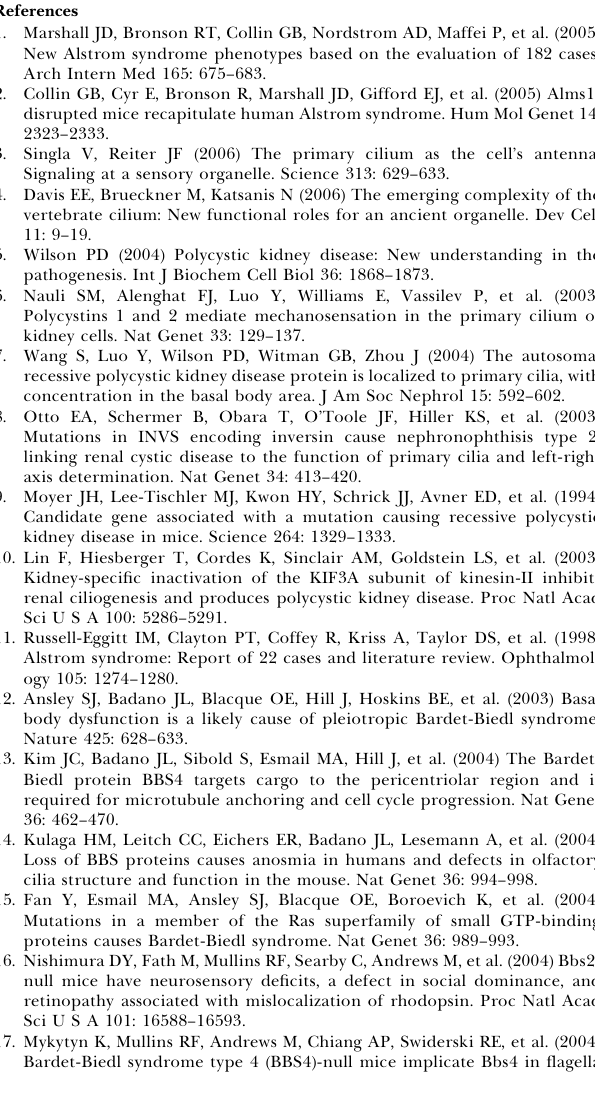
black shading denotes the included region for the position of the mutation and gray shading denotes the excluded region. Map positions refer to public mouse genome assembly M33 (http://www. ensembl.org/Mus_musculus/index.html). (B) Resequencing Alms1 gene in mutant mice showing nonsense mutation at exon 10. Schematic structure of Alms1 was drawn to scale